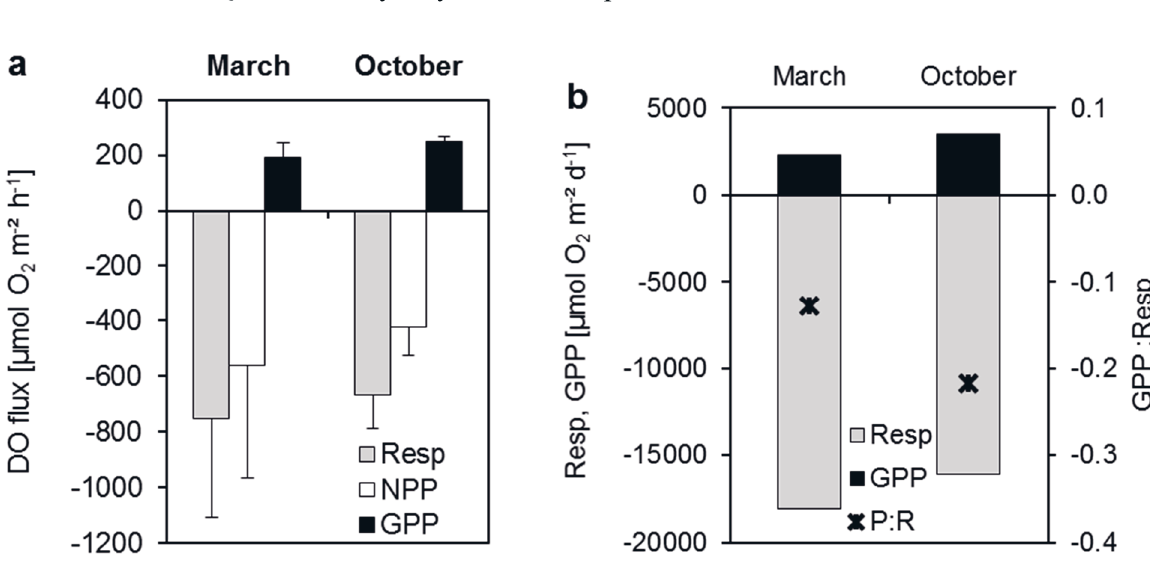
Figure 5. Hourly ( a ) and diel ( b ) total fluxes of dissolved oxygen. Respiration (Resp) equals measured dark fluxes, net primary production (NPP) equals measured light fluxes, and gross primary production (GPP) is calculated as their difference. Panel ( b ) also shows the ratio of GPP to respiration